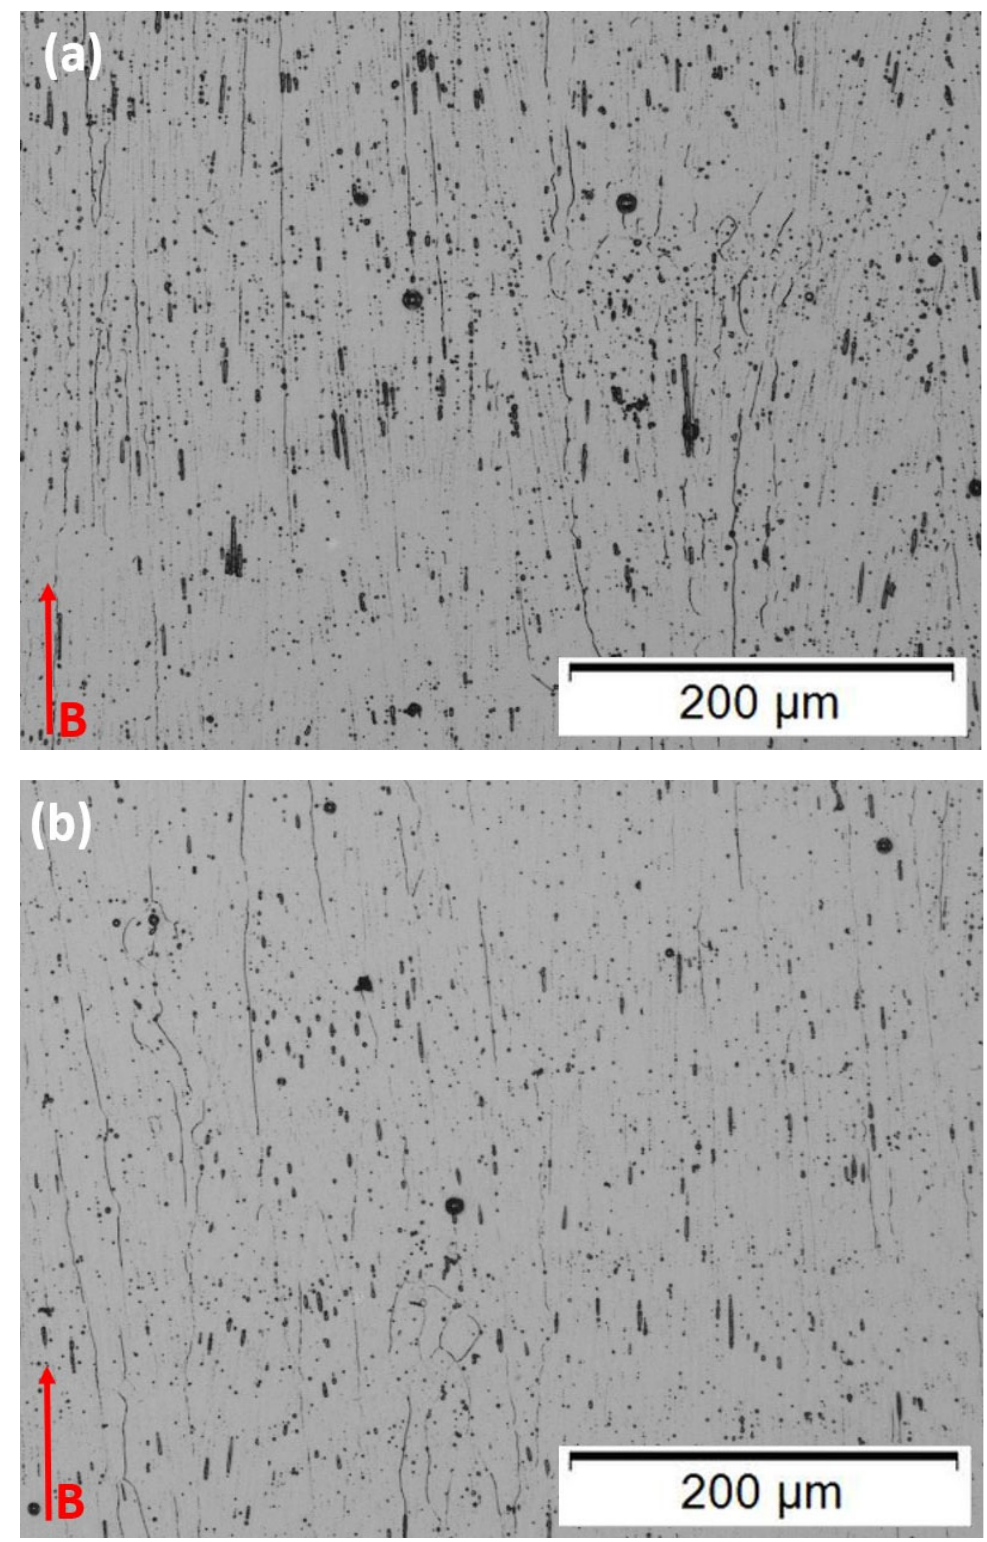
Figure 4. As-built samples viewed in the build plane. Build direction is shown at B. ( a ) 50 µm, layer thickness; ( b ) 100 µm layer thickness. thickness; ( b ) 100 µ m layer